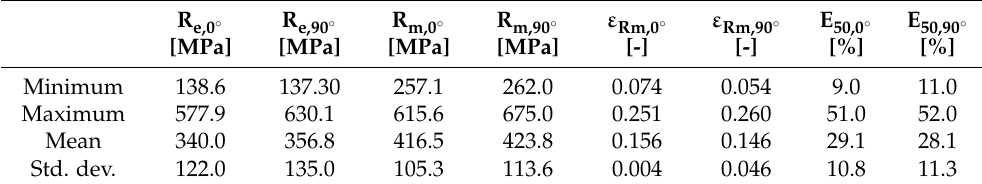
Table 1. Distribution of the tensile test